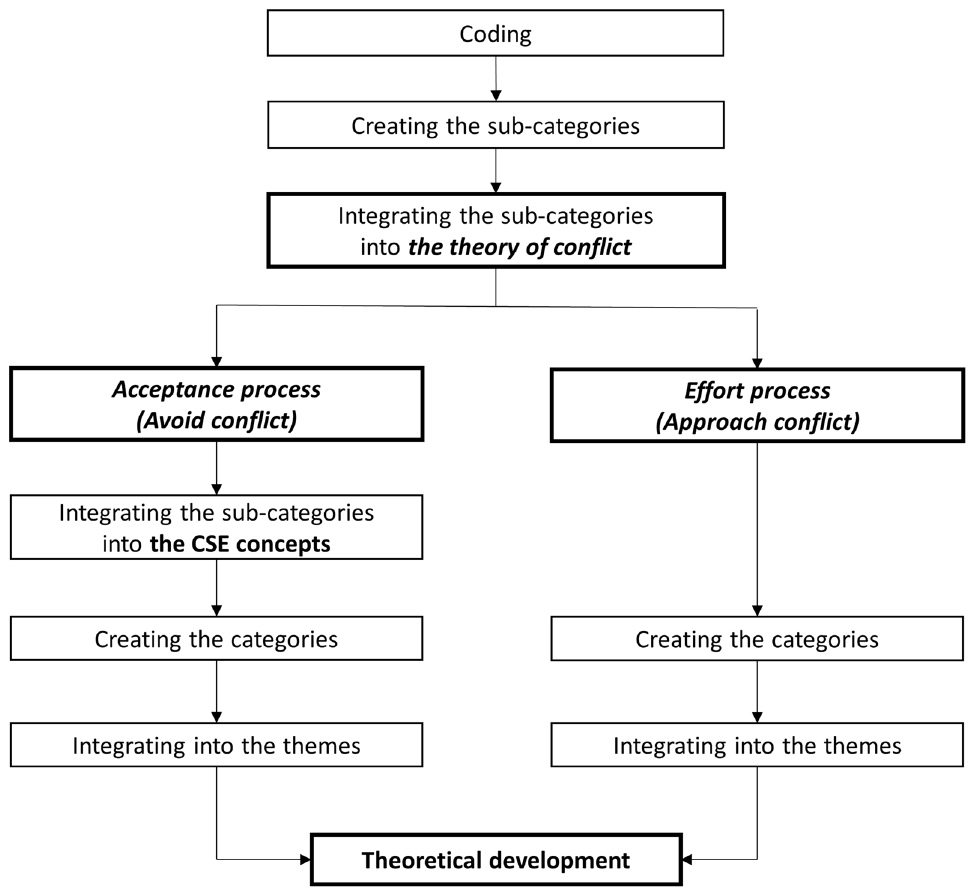
Fig. 1 Flowchart of deductive thematic